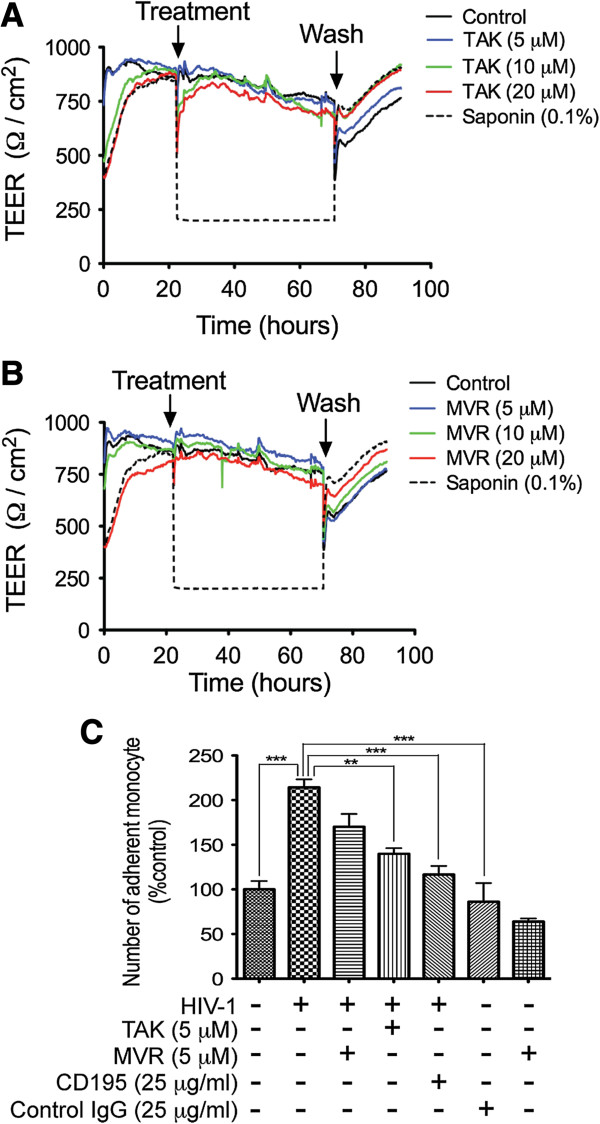
Effects of CCR5 antagonists on the BBB integrity and function. Confluent HBMEC monolayers were treated with TAK-799 (A) or maraviroc (MVR) (B), and TEER measured in real-time before and after exposures. At 5, 10, or 20 μM, TAK-799 (A) or maraviroc (B) did not alter TEER. TEER values were similar during treatment and when cells were washed to remove CCR5 antagonists. Controls consisted of mock-treated cells and cells treated with 0.1% saponin. Saponin-induced decrease in TEER was reversed upon removal of saponin from the media. (C) HIV-1 increased monocyte adhesion to HBMEC and CCR5 antagonists and neutralizing CCR5 antibodies decreased viral-induced monocyte adhesion (**P < 0.01; ***P < 0.001).